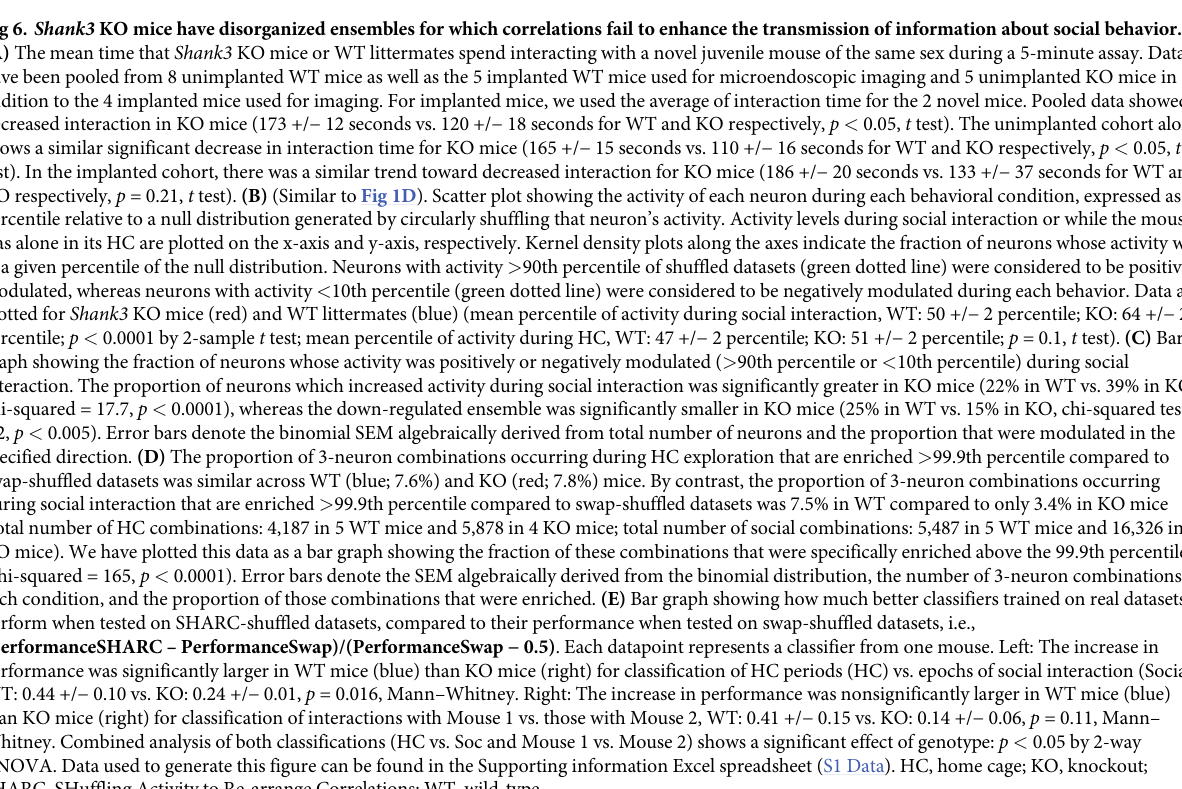
Fig 6. Shank3 KO mice have disorganized ensembles for which correlations fail to enhance the transmission of information about social behavior. (A) The mean time that Shank3 KO mice or WT littermates spend interacting with a novel juvenile mouse of the same sex during a 5-minute assay. Data have been pooled from 8 unimplanted WT mice as well as the 5 implanted WT mice used for microendoscopic imaging and 5 unimplanted KO mice in addition to the 4 implanted mice used for imaging. For implanted mice, we used the average of interaction time for the 2 novel mice. Pooled data showed decreased interaction in KO mice (173 +/ − 12 seconds vs. 120 +/ − 18 seconds for WT and KO respectively, p < 0.05, t test). The unimplanted cohort alone shows a similar significant decrease in interaction time for KO mice (165 +/ − 15 seconds vs. 110 +/ − 16 seconds for WT and KO respectively, p < 0.05, t test). In the implanted cohort, there was a similar trend toward decreased interaction for KO mice (186 +/ − 20 seconds vs. 133 +/ − 37 seconds for WT and KO respectively, p = 0.21, t test). (B) (Similar to Fig 1D ). Scatter plot showing the activity of each neuron during each behavioral condition, expressed as a percentile relative to a null distribution generated by circularly shuffling that neuron’s activity. Activity levels during social interaction or while the mouse was alone in its HC are plotted on the x-axis and y-axis, respectively. Kernel density plots along the axes indicate the fraction of neurons whose activity was at a given percentile of the null distribution. Neurons with activity > 90th percentile of shuffled datasets (green dotted line) were considered to be positively modulated, whereas neurons with activity < 10th percentile (green dotted line) were considered to be negatively modulated during each behavior. Data are plotted for Shank3 KO mice (red) and WT littermates (blue) (mean percentile of activity during social interaction, WT: 50 +/ − 2 percentile; KO: 64 +/ − 2 percentile; p < 0.0001 by 2-sample t test; mean percentile of activity during HC, WT: 47 +/ − 2 percentile; KO: 51 +/ − 2 percentile; p = 0.1, t test). (C) Bar graph showing the fraction of neurons whose activity was positively or negatively modulated ( > 90th percentile or < 10th percentile) during social interaction. The proportion of neurons which increased activity during social interaction was significantly greater in KO mice (22% in WT vs. 39% in KO, chi-squared = 17.7, p < 0.0001), whereas the down-regulated ensemble was significantly smaller in KO mice (25% in WT vs. 15% in KO, chi-squared test, 8.2, p < 0.005). Error bars denote the binomial SEM algebraically derived from total number of neurons and the proportion that were modulated in the specified direction. (D) The proportion of 3-neuron combinations occurring during HC exploration that are enriched > 99.9th percentile compared to swap-shuffled datasets was similar across WT (blue; 7.6%) and KO (red; 7.8%) mice. By contrast, the proportion of 3-neuron combinations occurring during social interaction that are enriched > 99.9th percentile compared to swap-shuffled datasets was 7.5% in WT compared to only 3.4% in KO mice (total number of HC combinations: 4,187 in 5 WT mice and 5,878 in 4 KO mice; total number of social combinations: 5,487 in 5 WT mice and 16,326 in 4 KO mice). We have plotted this data as a bar graph showing the fraction of these combinations that were specifically enriched above the 99.9th percentile (chi-squared = 165, p < 0.0001). Error bars denote the SEM algebraically derived from the binomial distribution, the number of 3-neuron combinations in each condition, and the proportion of those combinations that were enriched. (E) Bar graph showing how much better classifiers trained on real datasets perform when tested on SHARC-shuffled datasets, compared to their performance when tested on swap-shuffled datasets, i.e., (PerformanceSHARC – PerformanceSwap)/(PerformanceSwap − 0.5) . Each datapoint represents a classifier from one mouse. Left: The increase in performance was significantly larger in WT mice (blue) than KO mice (right) for classification of HC periods (HC) vs. epochs of social interaction (Social), WT: 0.44 +/ − 0.10 vs. KO: 0.24 +/ − 0.01, p = 0.016, Mann–Whitney. Right: The increase in performance was nonsignificantly larger in WT mice (blue) than KO mice (right) for classification of interactions with Mouse 1 vs. those with Mouse 2, WT: 0.41 +/ − 0.15 vs. KO: 0.14 +/ − 0.06, p = 0.11, Mann– Whitney. Combined analysis of both classifications (HC vs. Soc and Mouse 1 vs. Mouse 2) shows a significant effect of genotype: p < 0.05 by 2-way ANOVA. Data used to generate this figure can be found in the Supporting information Excel spreadsheet (S1 Data). HC, home cage; KO, knockout; SHARC, SHuffling Activity to Re-arrange Correlations; WT,